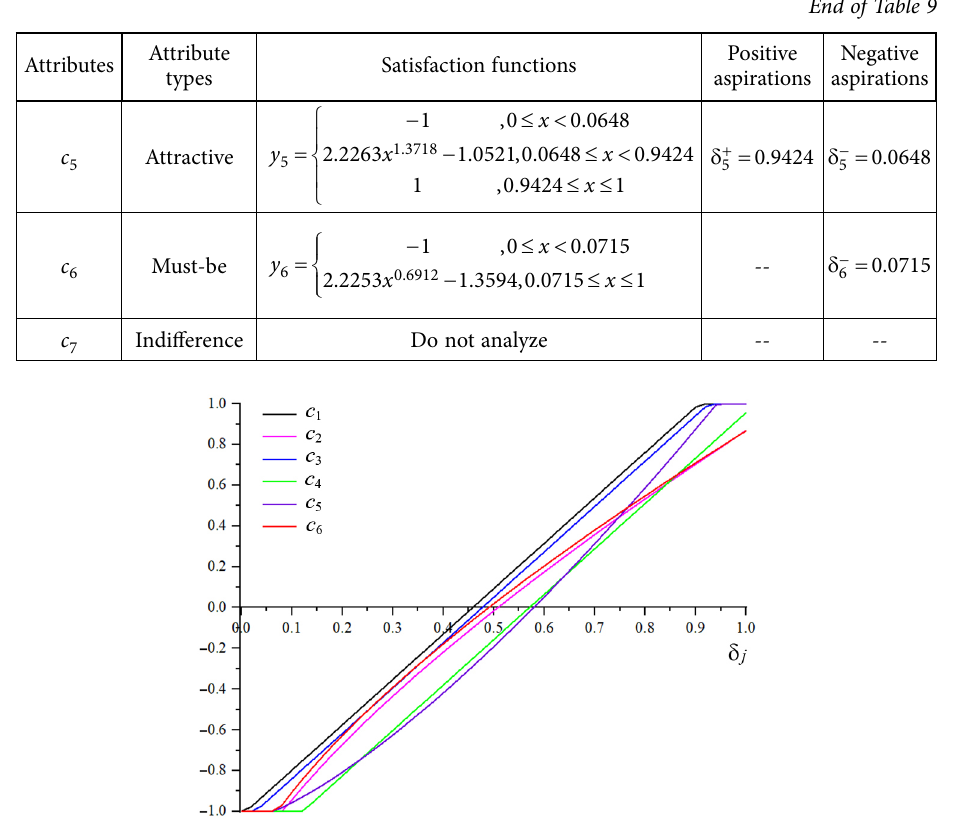
Figure 13. The image of satisfaction